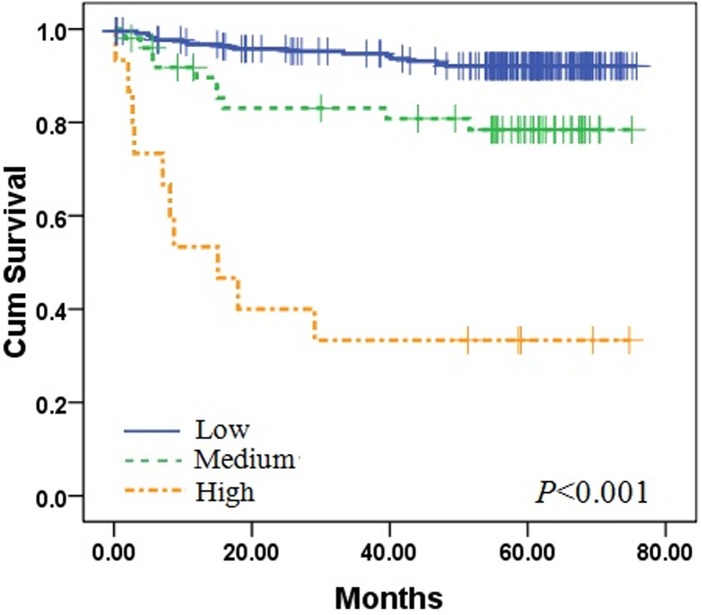
Three-tiered stratification of patients with endometrial cancer, incorporating two independent prognostic variables (CRP and D-D Concentrations).Survival in low-risk (CRP <8.2 mg/l and D-D <1.5 mg/l), medium-risk (CRP ≥8.2 mg/l, or D-D ≥1.5 mg/l), and high-risk (CRP ≥8.2 mg/l and D-D ≥1.5 mg/l) groups differed significantly (log-rank test used to calculate P-values).